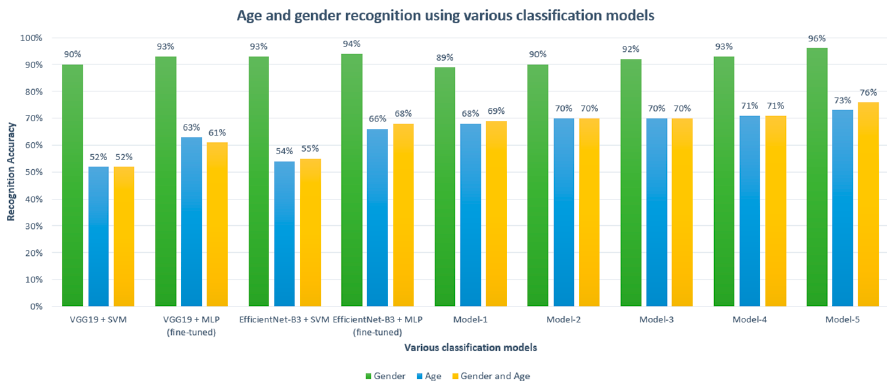
Figure 7. The recognition accuracy of various classification models for the classification of age, gender, and age-gender for the Common Voice dataset.